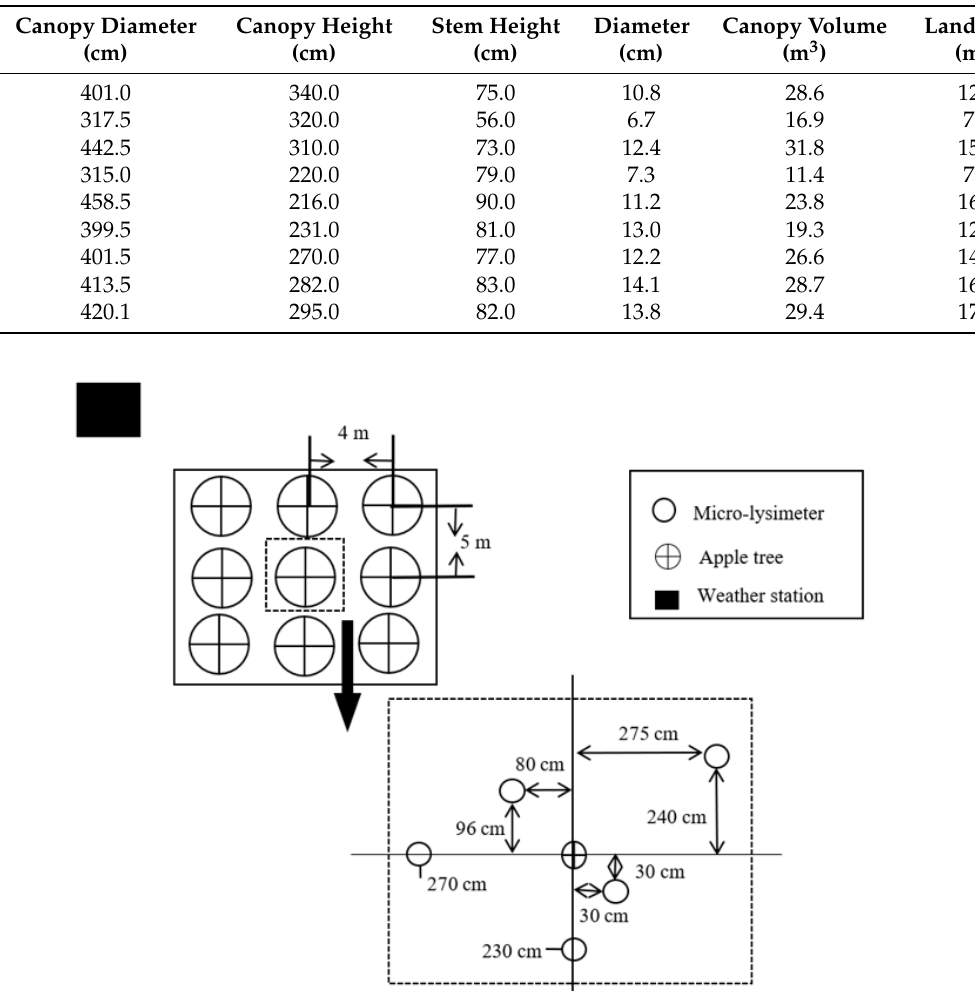
Table 1. The canopy structure of apple trees.